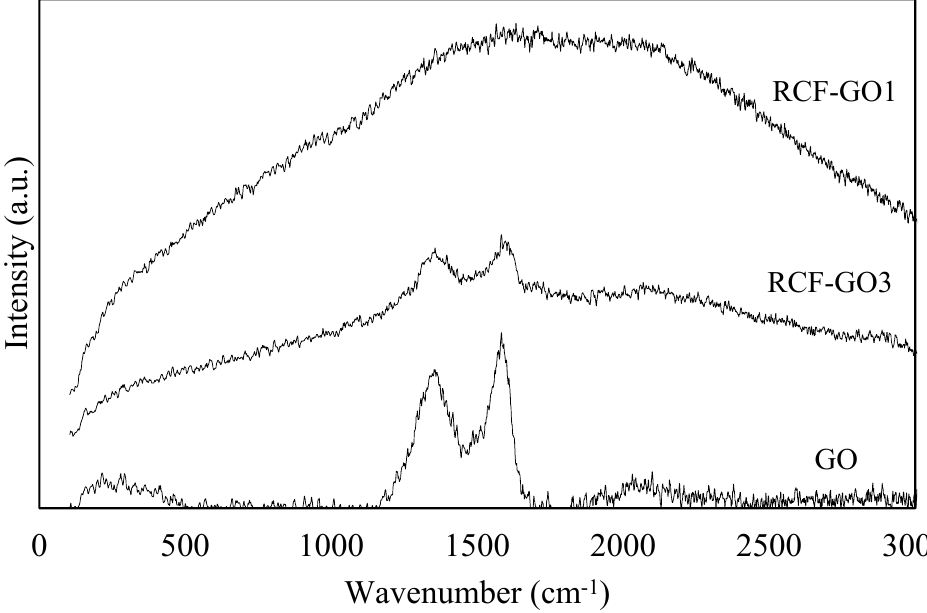
Figure 2. Raman spectrum of graphene oxide (GO), RCF − GO1, and RCF − GO3. The fact that RCF − GO1 does not exhibit any pronounced peaks suggests that the GO is encapsulated within the cellulose matrix. Due to the low concentration, Raman spectroscopy was not able to detect it, indicating that there was less GO present on the surface of the RCFs. However, RCF − GO3 shows visible bands at 1353 and 1600 cm − 1 for the D − band and G − band, respectively. The D − band and G − band peaks in RCF − GO3 are less intense than in pure GO because only 3 wt.% of the GO is presented and embedded inside the cellulose matrix. Nonetheless, these peaks verified that GO is also present on the surface of the RCFs’ composite. The I D /I G ratio for RCF − GO3 is 0.98, which is lower than that of pure GO. The I D /I G ratio is closely related to the crystallinity of the samples. As the crystallinity increases, the I D /I G ratio decreases. Given that the GO in RCF − GO3 had intercalated with the cellulose, this result makes sense. As a result, the composite’s crystallinity